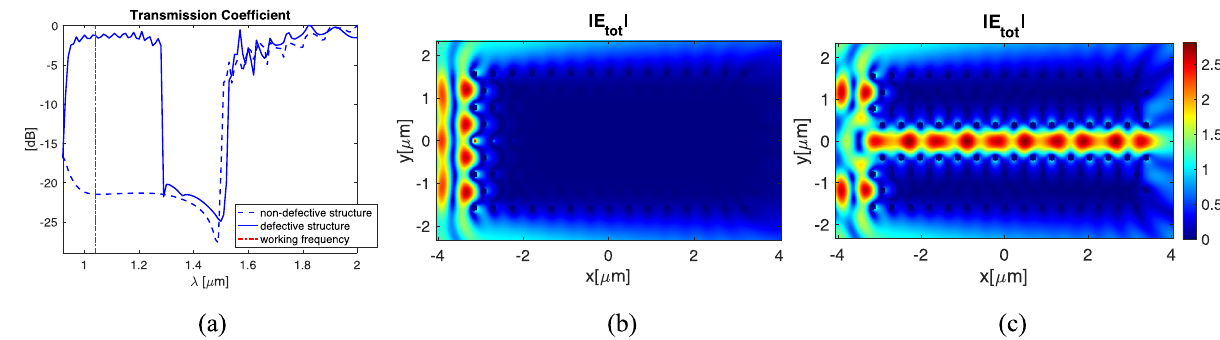
Fig. 2. Electromagnetic fi eld propagation mechanism for EBG devices. (a) Band-map in logarithmic scale. Amplitude of electric fi eld with l =1.04 m m for (b) non-defective and (c) defective EBG